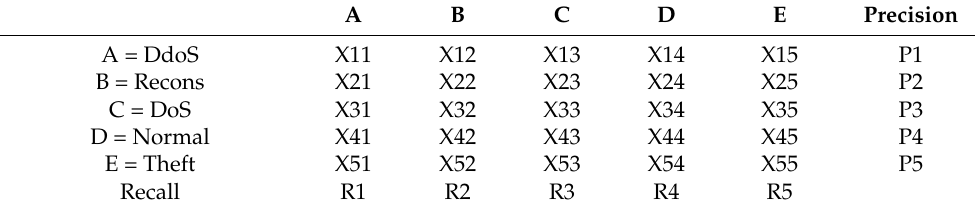
Table 2. Confusion matrix with five